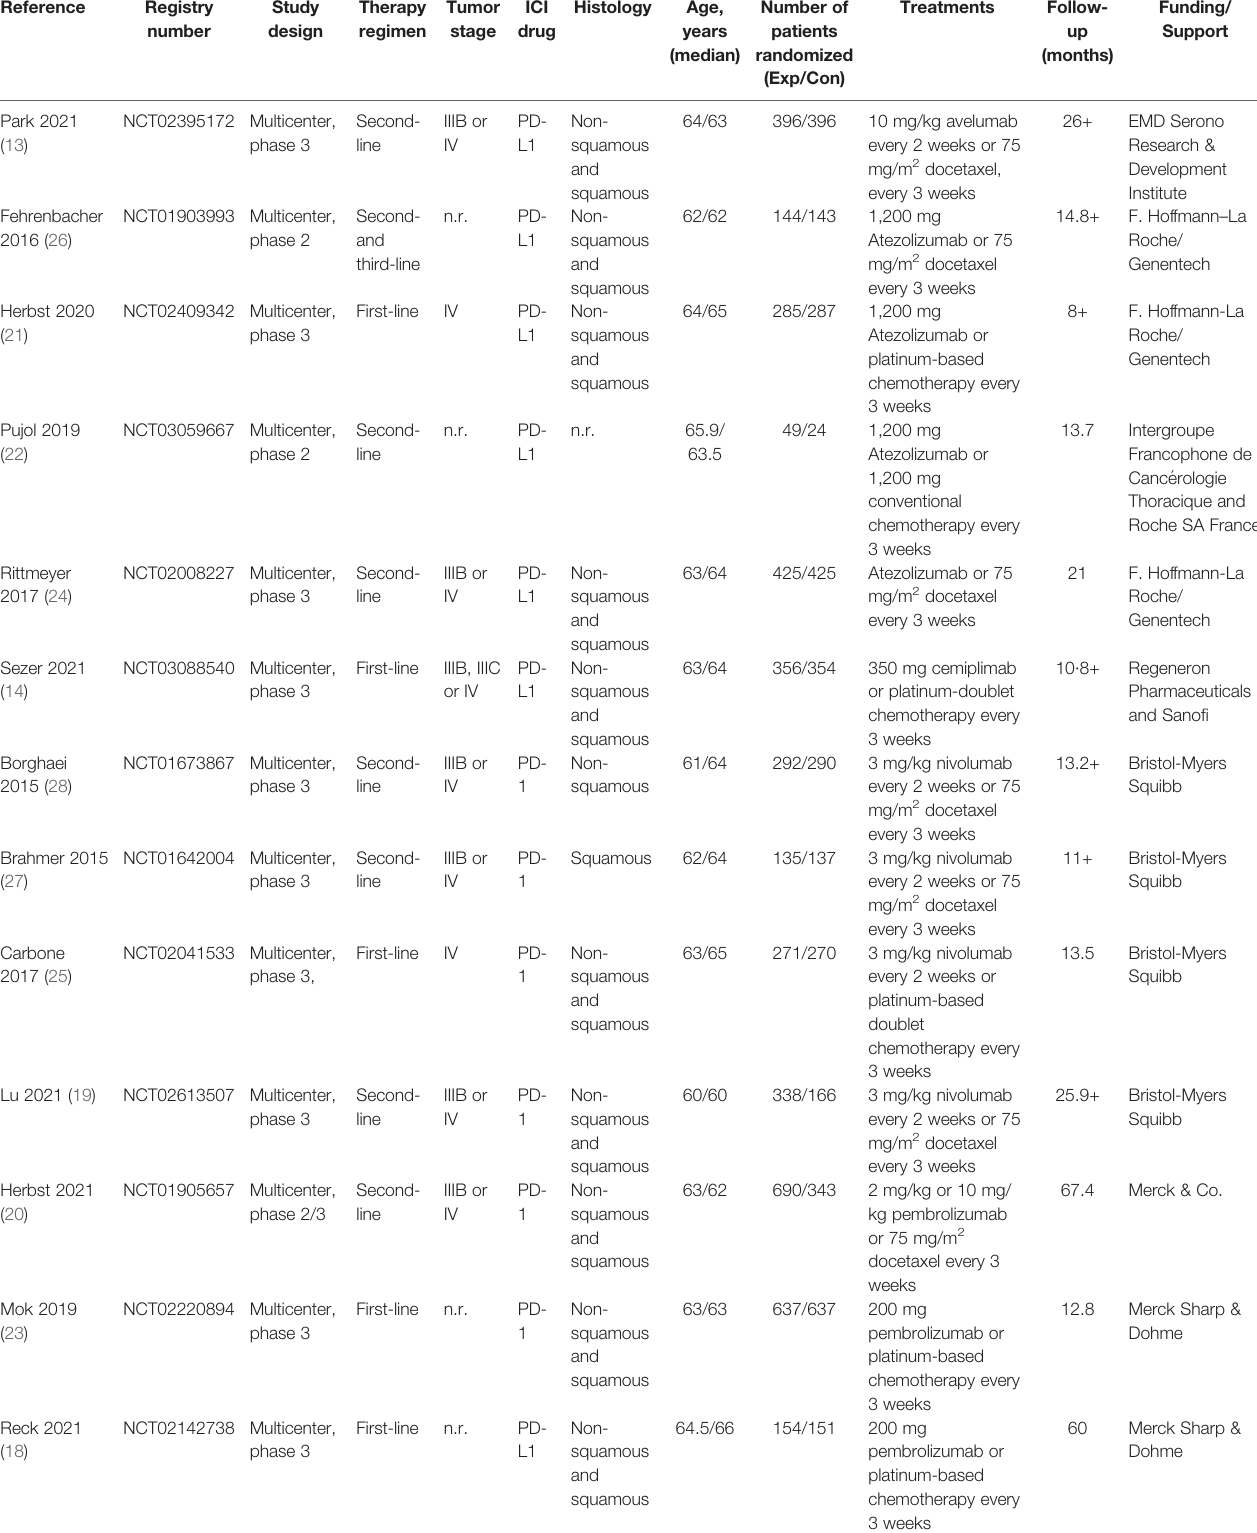
TABLE 1 | Characteristics of the 13 trials included in the network